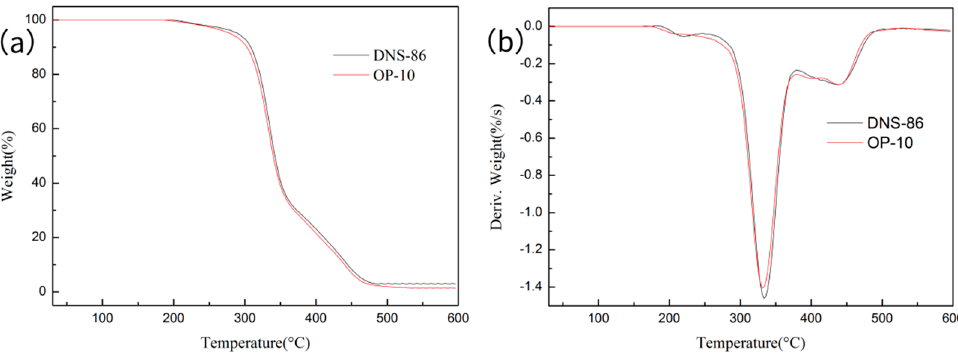
Figure 7. TG ( a ) –DTG ( b ) curve of the latex film with 4% DNS-86 and 5% OP-10.